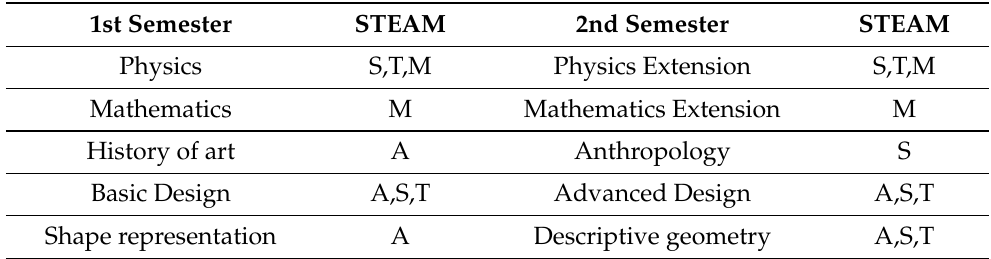
Table 1. 1st year STEAM subjects from the Degree in Industrial Design and Product